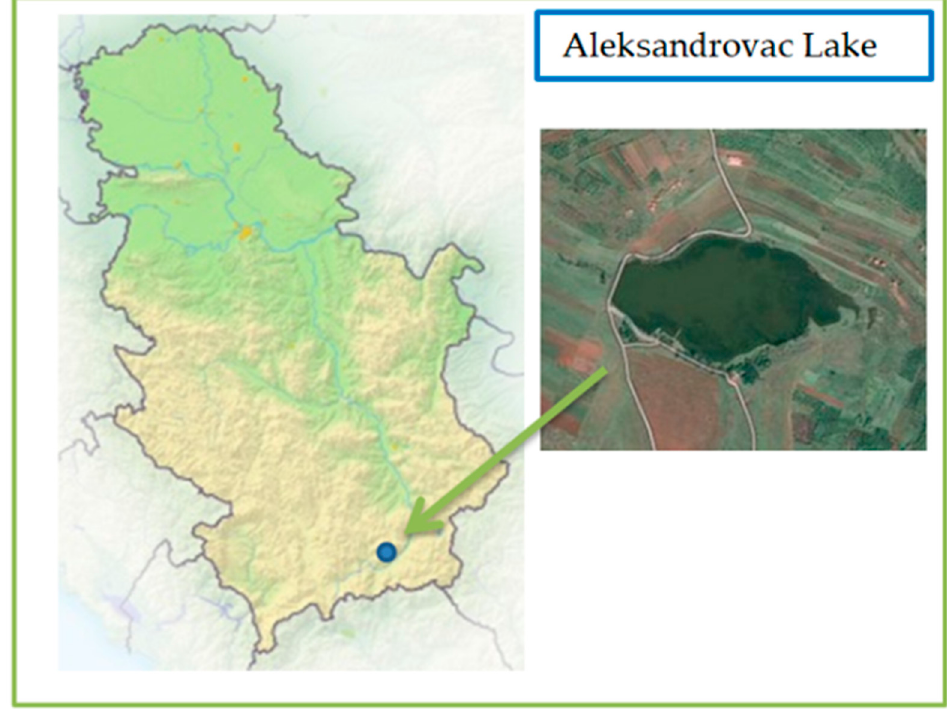
Figure 1. Satellite view of Aleksandrovac Lake, Serbia.